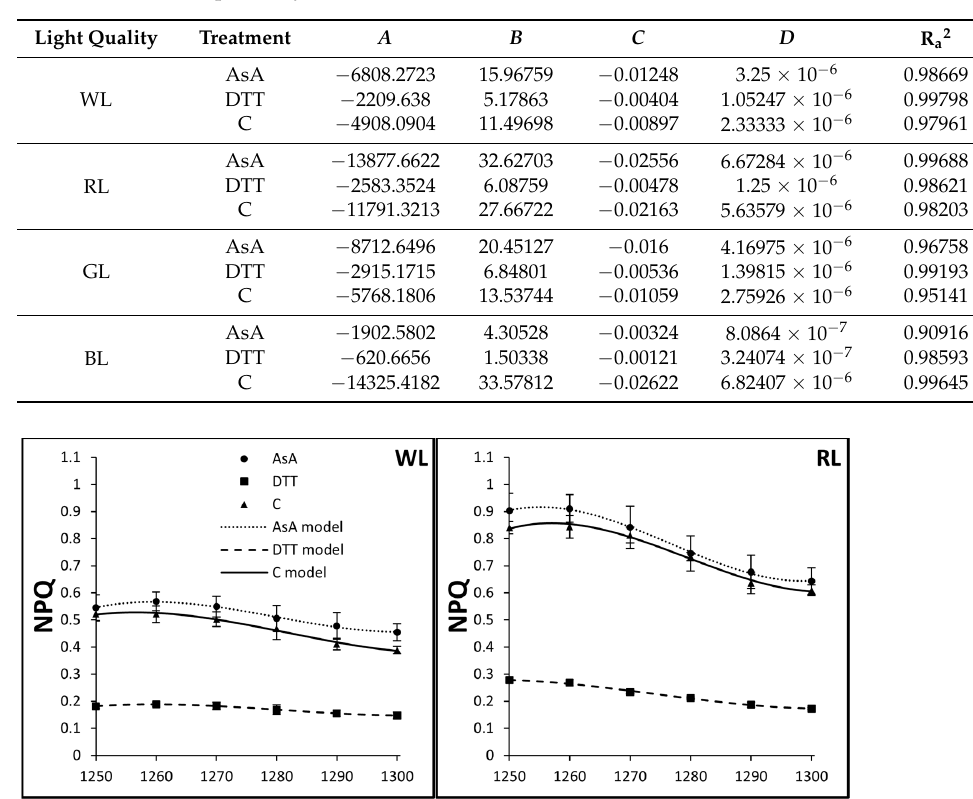
Table 2. The parameters of the polynomial cubic regression model employed to fit the experimental data ( x ) of fast (50 s) qE NPQ relaxation in the AsA-, DTT- or water-treated samples (C). The fit equation: y = A + Bx + Cx 2 + Dx 3 , where A —offset, B , C and D —coefficients, R a2 —the adjusted r-square value, determining the goodness of fit, accounts for the degrees of freedom. WL—the R:G:B = 1:1:1 at 120 µ mol m –2 s –1 ; RL, GL or BL—monochromatic red (R), green (G) or blue (B) light (L) at 80 µ mol m –2 s –1 , respectively.